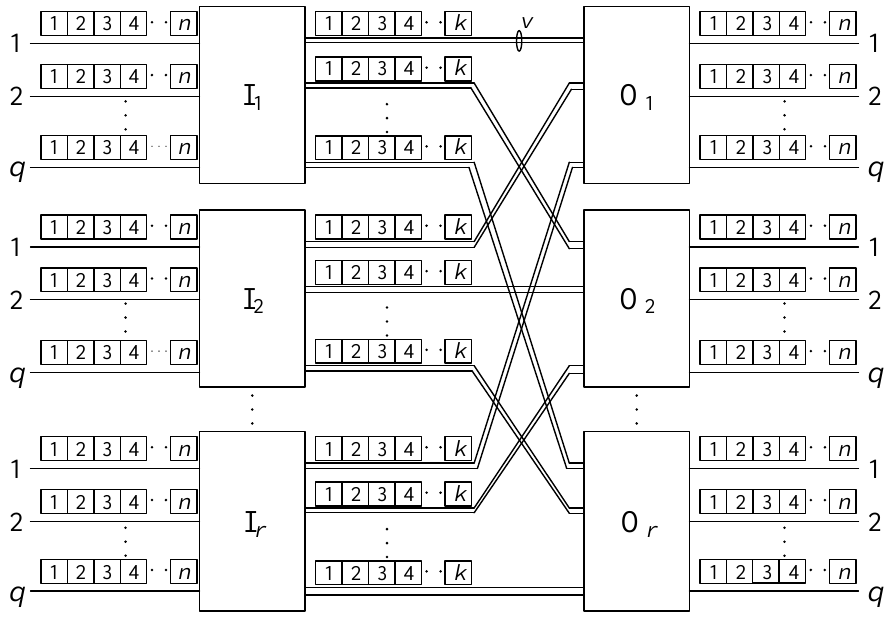
Figure 1. An CC ( q , r , v , n , k ) switching network.